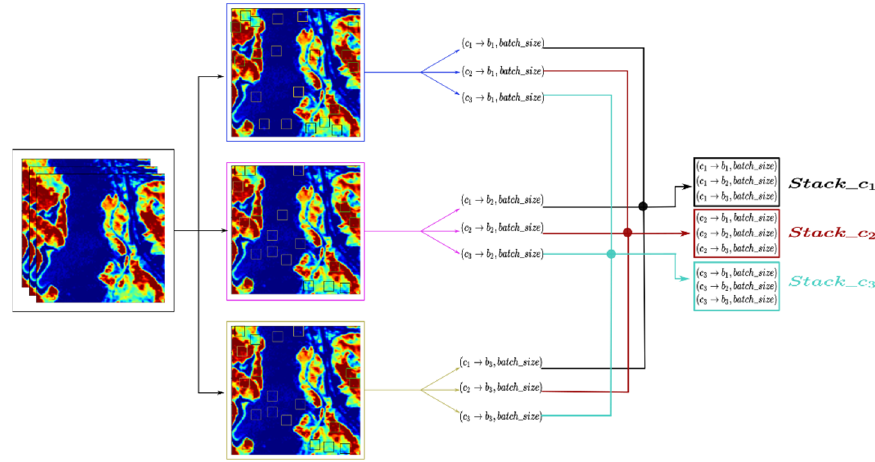
Figure 5. Batch size selection process for the three PCA bands from the Jasper HSI.